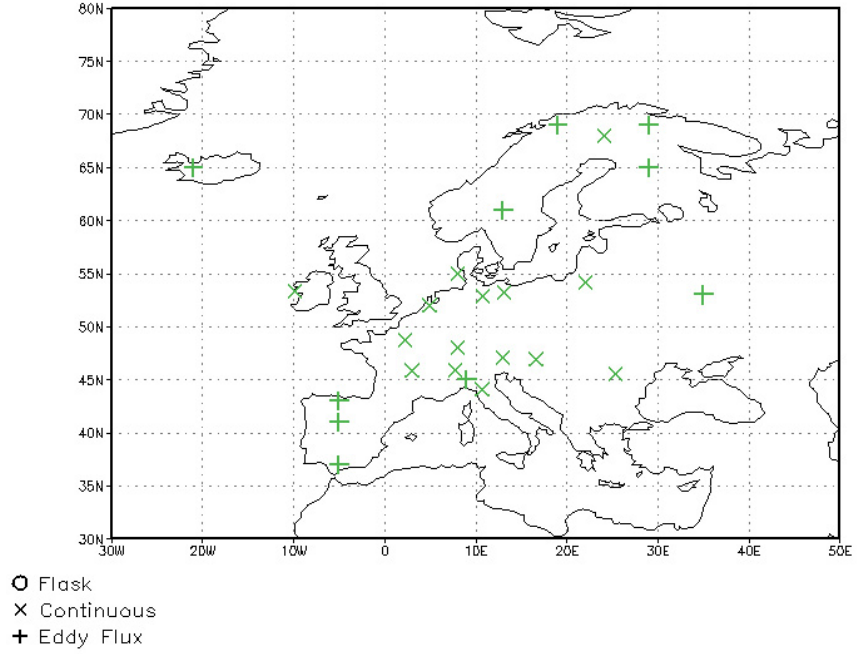
Fig. 4. Observational networks flux ( + ) providing flux measurements and cont (X) providing continuous atmospheric samples.